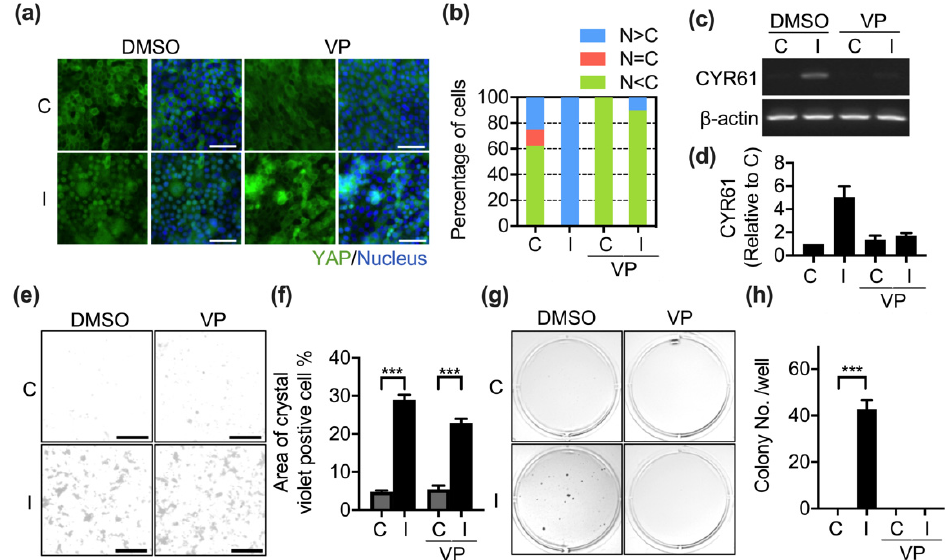
Figure 5. Activation of YAP is required for Ha-Ras V12 -induced colony formation, but not multilayer cellular aggregation. MK4 cells at the overconfluent stage were pretreated with verteporfin (VP, 5 µM, YAP-TEAD binding inhibitor) for 2 h before administering with or without IPTG (5 mM) for a further 24 h: ( a ) Representative immunofluorescence images of cells at overconfluent stage, which were stained with YAP (green) and Hoechst 33,258 (blue). Scale bar = 50 µm. ( b ) Percentage of cells